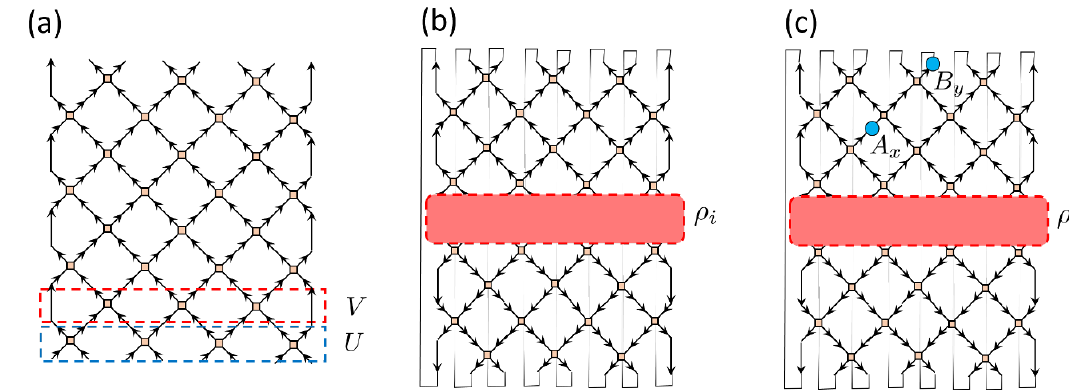
Figure 3 . (a) An example of a tensor network describing a unitary operator W = ( V U ) M . Each vertex is a two-qubit unitary gate with the inputs and outputs indicated by arrows pointing toward or away from the vertex, respectively. (b) This is the tensor network obtained by contracting W and W with an initial state ρ (the red box), and then taking a trace. In other words, the tensor † i ) = tr( ρ ) = 1. (c) The tensor network representation of a two-point network computes tr( Wρ i W † i function defined in eq.